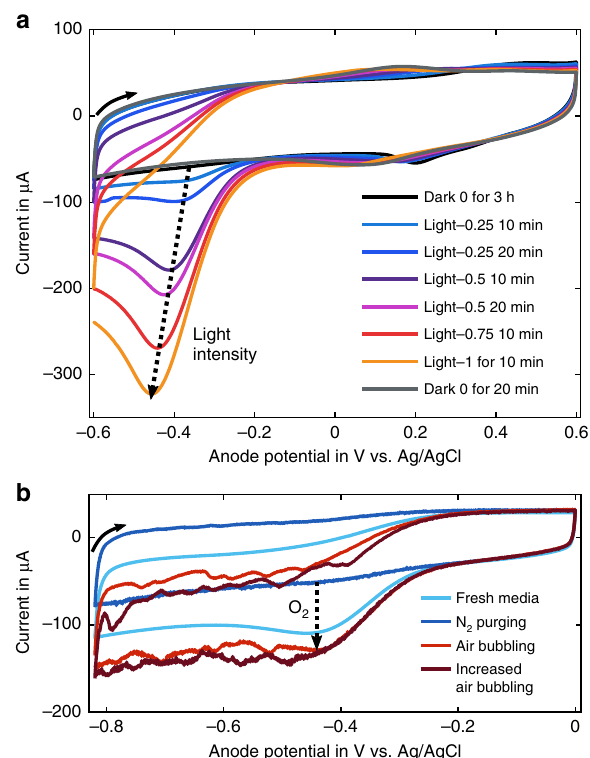
Fig. 7 Cyclic voltammetry analysis of microporous ITO anodes at a scan rate of 4 mV s − 1 with BG11 medium as electrolyte. a Response of the bio- anode ( Synechocystis ) under exposure to different constant light levels. Light intensity 1 corresponds to a photon fl ux of 820 µ mol m − 2 s − 1 , and the time indicates for how long the light level was applied by the end of the measurement. b Scans of abiotic anodes in the dark. The oxygen content of the electrolyte was varied by purging the electrolyte with nitrogen gas